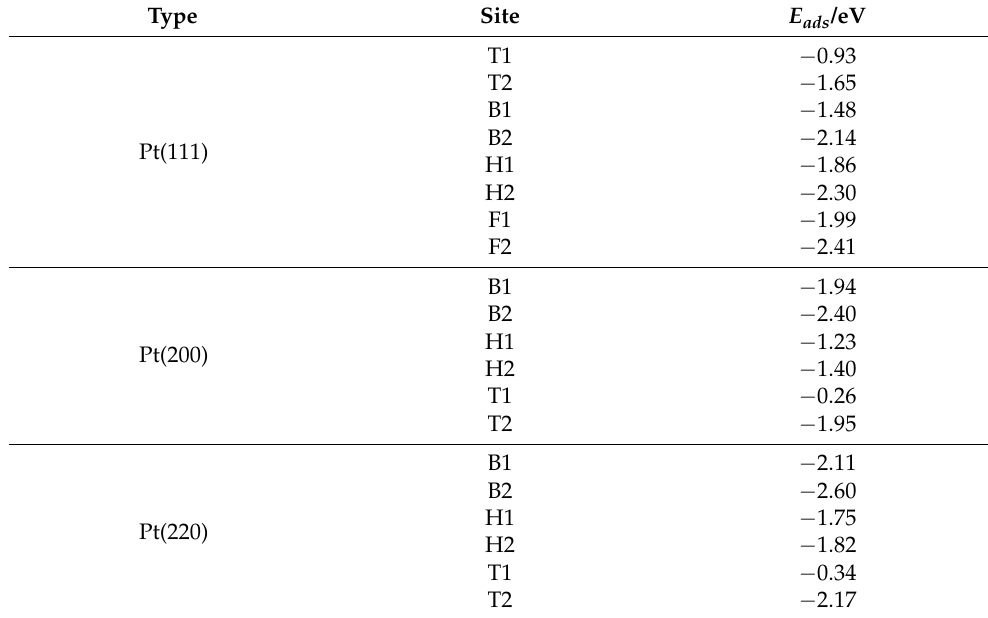
Table 2. Adsorption energies of Au single atoms for NO on Pt(111), Pt(200), and Pt(220) surfaces.